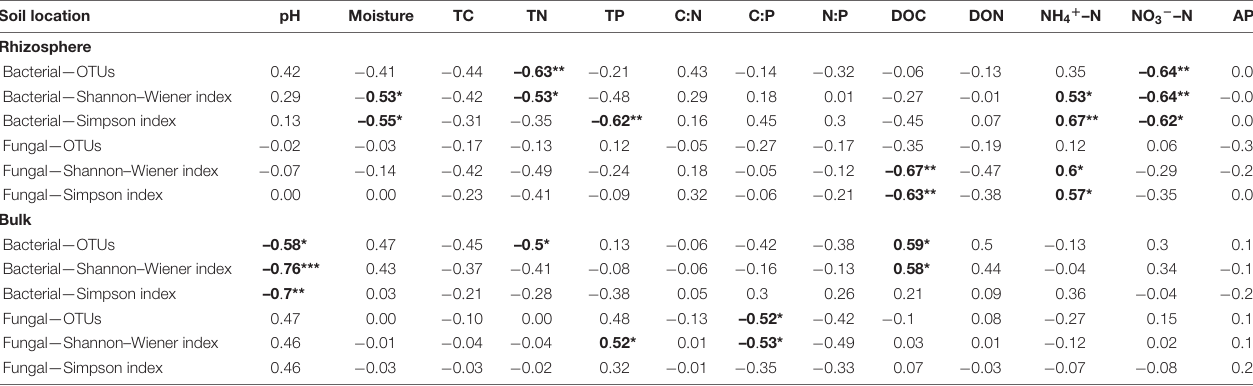
TABLE 3 | Pearson correlation coefficients between bacterial, fungal alpha diversity, and environmental